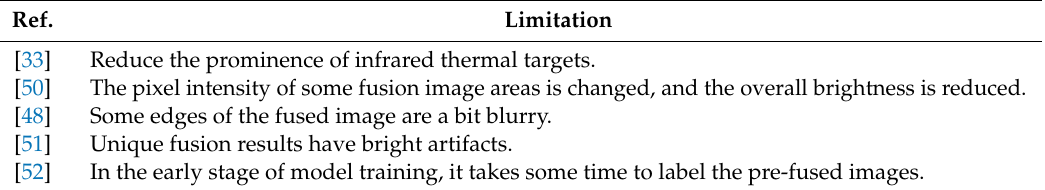
Table 4. The overview of some GAN-based fusion methods.